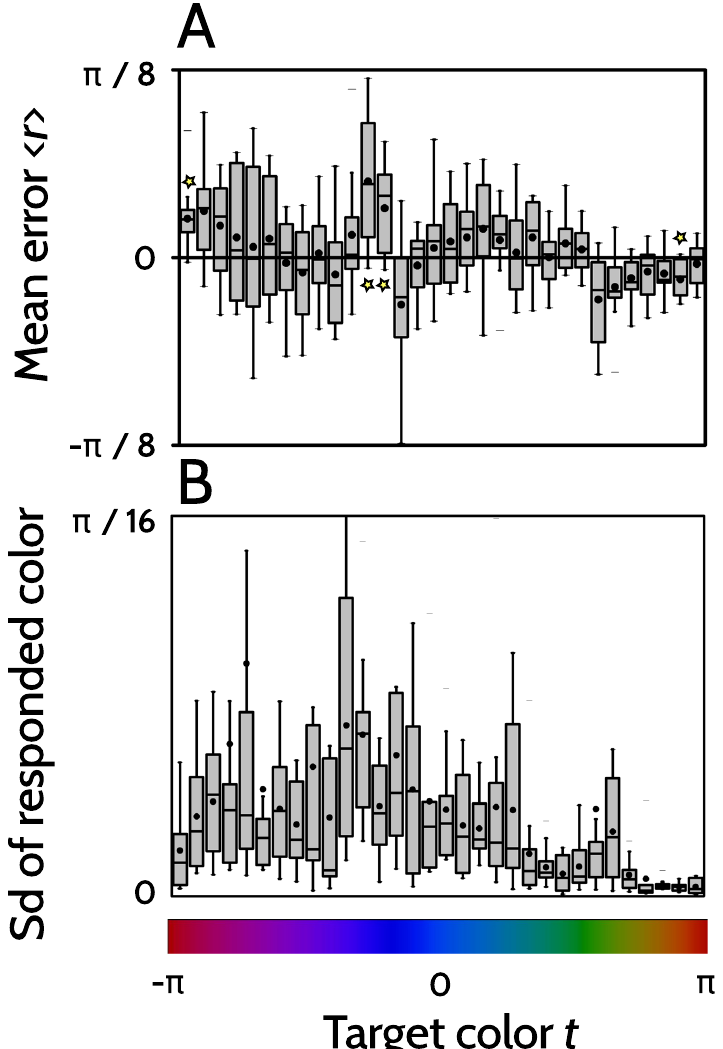
Fig 5. Sample statistics of the recorded responses. Sample histogram of the mean error � r ð t Þ (cid:0) t (panel A), and of the responses’ standard deviation � ( t ) (panel B) for the 11 players. In A, the yellow stars indicate the target colors for which a two-sided t -test evaluating whether � r (cid:0) t is significantly different from zero yields a particularly small p value . From left to right: p = 0.004, 0.004, 0.004 and 0.002. Boxed-histogram conventions same as in Fig 4. attractor colors and of repulsor colors for each player, both of which can be linked to the con- cept of categorical memory. The advantage of assessing categorization with a measure defined in terms of the mean (as opposed to the spread) is that the mean is less sensitive to the choice of coordinates than the spread. Imagine, for example, that when memorizing a certain shade of blue, a given player tends to retrieve colors that are shifted towards the violet side. The spread of the responses may be large or small, depending on the chosen coordinates. In fact, by performing a nonlinear change of coordinates that expands or contracts the responded col- ors, the spread will appear to increase or diminish accordingly. However, the fact that the majority of responses are systematically biased towards the violet side (as opposed to the green side) does not depend on the choice of coordinates.